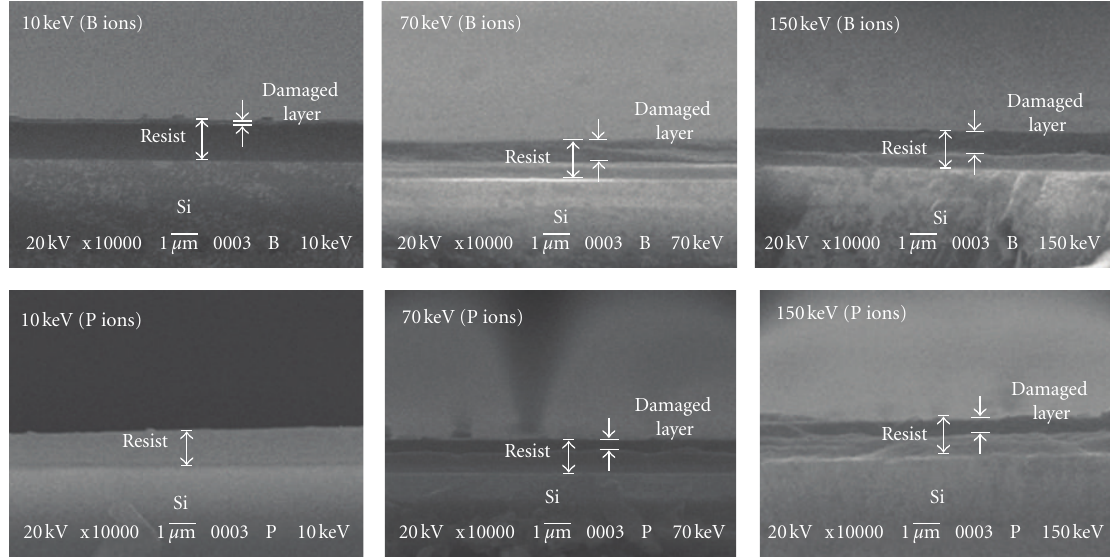
Figure 5: SEM images of B and P ion-implanted resist with various acceleration energies.